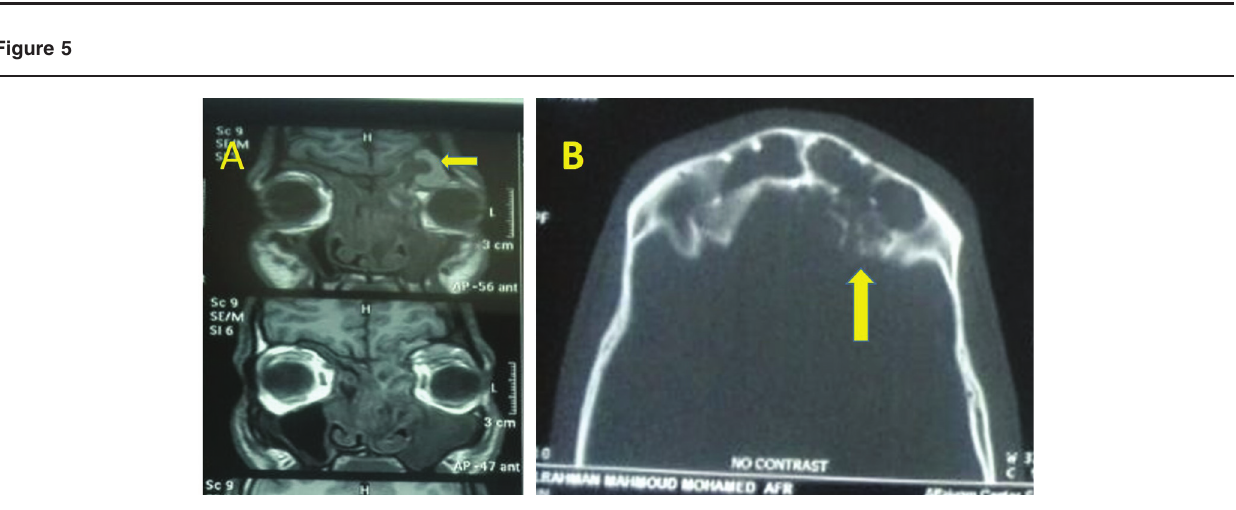
Bilateral frontal pneumatization reaching not extending beyond midorbital plane, with no supraorbital cells, was recorded. Skull 3 Right frontal pneumatization reaching to midorbital plane and left hypoplastic pneumatization reaching the medial orbital wall were recorded. Skull 4 Bilateral hypoplastic frontal sinus just reaching media orbital walls was recorded.